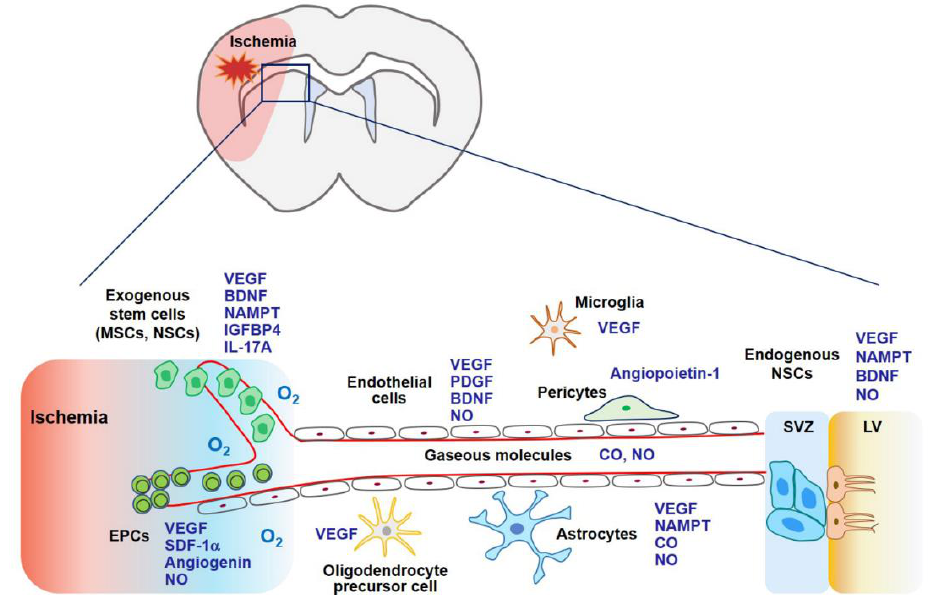
Figure 3. In the later phase of an ischemic stroke, VEGF expression may facilitate tissue regeneration. Exogenous stem cells (i.e., MSCs, EPCs, and NSCs) and gaseous molecules (i.e., NO and CO) increase the expression of VEGF and its related factors, which are involved in angiogenesis, neurogenesis, and synaptogenesis. Additionally, these factors enhance the ability of endogenous NSCs to proliferate and differentiate into mature neurons, astrocytes, and oligodendrocytes. Collectively, regeneration through stem cells and gaseous molecules contributes to repair after an ischemic stroke. Abbrevi- ations: MSCs, mesenchymal stem cells; NSCs, neural stem cells; EPCs, endothelial precursor cells; BDNF, brain-derived neurotrophic factor; IGFBP4, insulin-like growth factor binding protein-4; PDGF, platelet-derived growth factor; SDF-1 α , stromal cell-derived factor-1 α ; SVZ, subventricular zone; LV, lateral